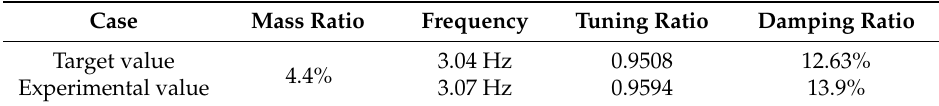
Table 4. Dynamic property of ECTMD.